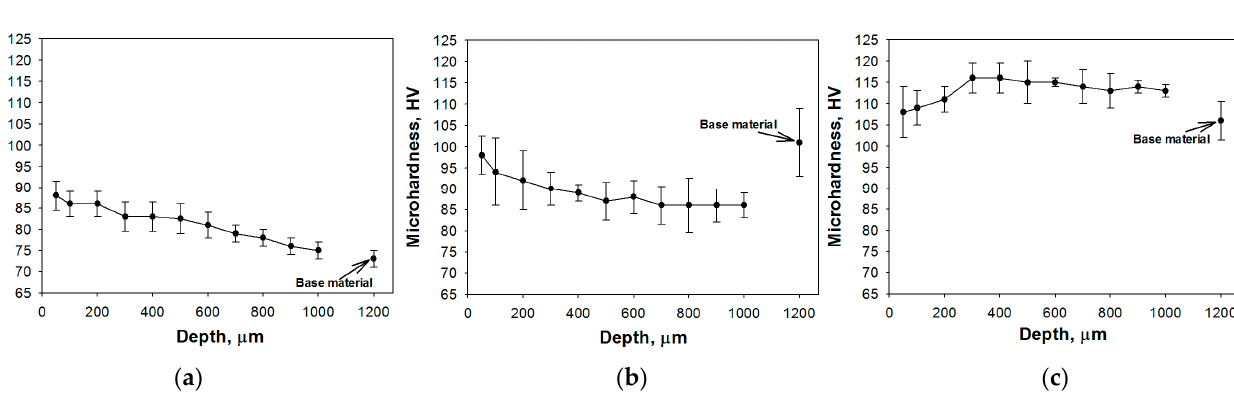
Figure 11. Distribution of microhardness from surface towards the ARMCO iron specimen center after LSP ( a ), without LSP after fatigue test ( b ) and after LSP and the fatigue test ( c ); microhardness for the base material was measured in the center of the specimens.